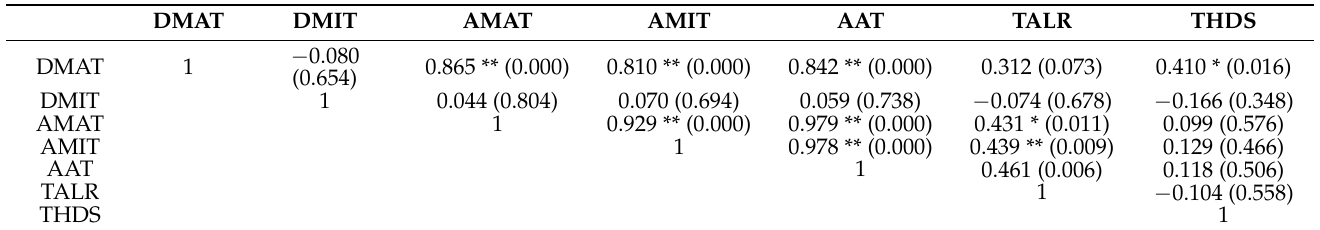
Table 5. Pearson correlation analysis of extreme weather and climate change for